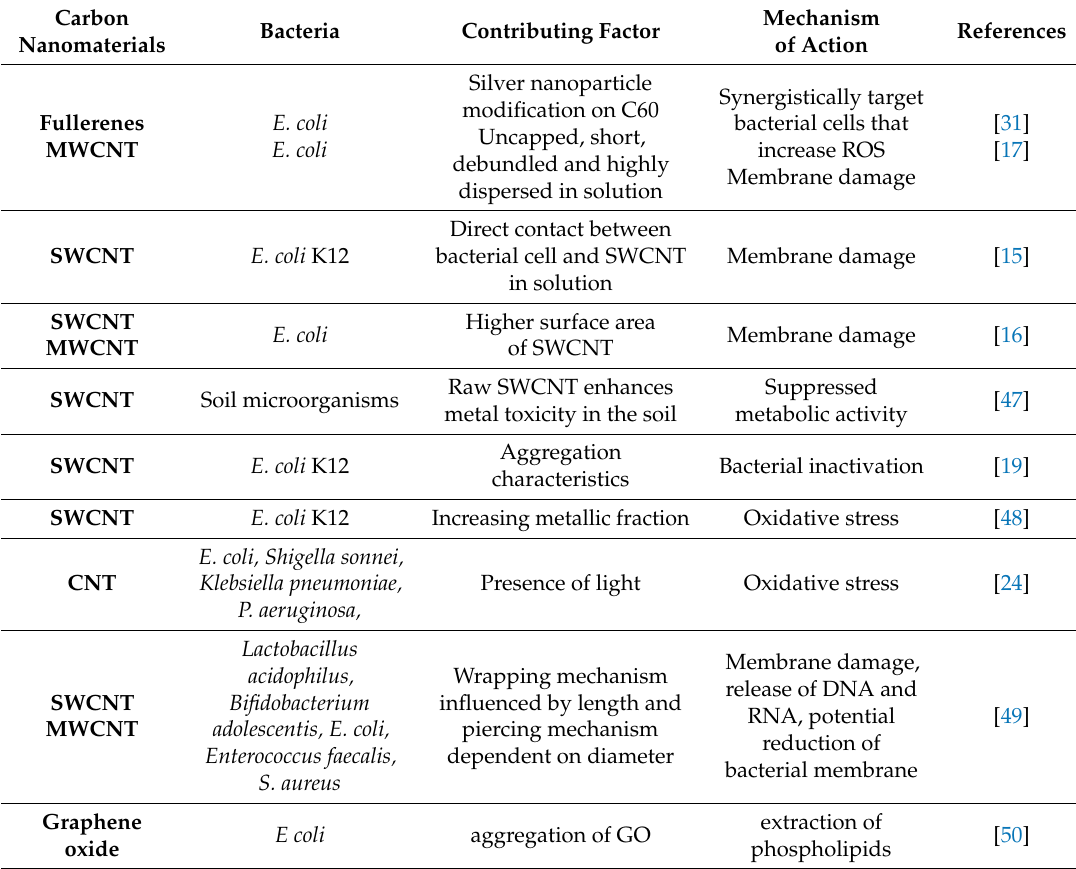
Table 1. Brief description of antibacterial activity and its mechanism insights of CNT